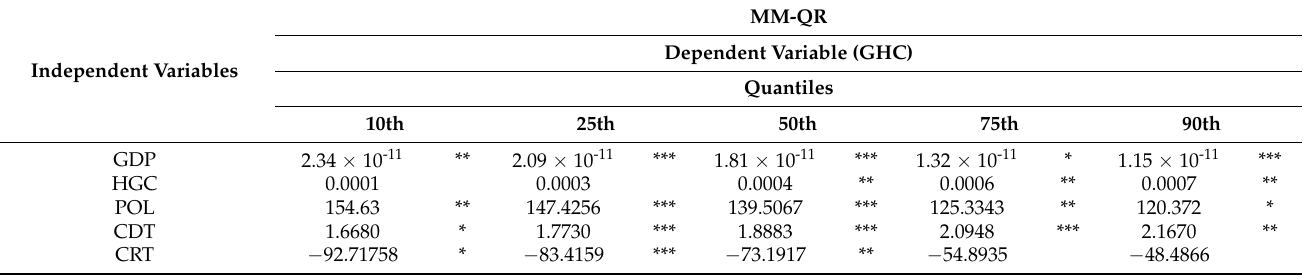
Table 10. Results from MM-QR.